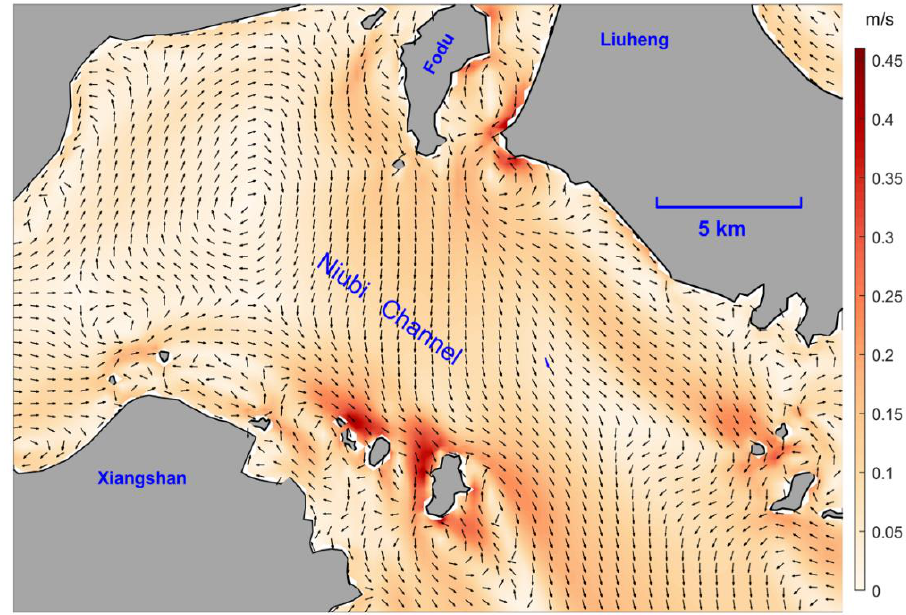
Figure 11. Vertical-averaged residual current distribution, where the black and blue unit vectors were obtained from Case3 and ADCP data, respectively. The red shading indicates the magnitudes of the residual currents (in m/s).